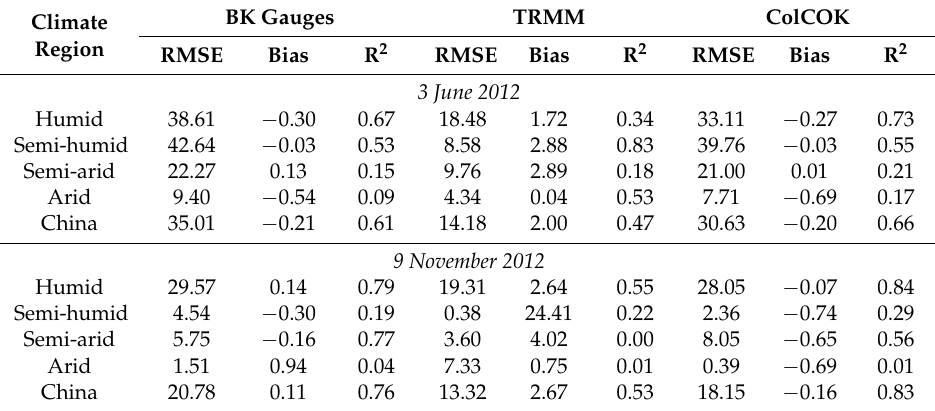
Figure 3. Maps of daily rainfall (mm) measured at ( a ) BK gauges, ( b ) Tropical Rainfall Measuring Mission (TRMM), and ( c ) collocated cokriging (ColCOK) for 3 June 2012; and ( d ) BK gauges, ( e ) TRMM, and ( f ) ColCOK for 9 November 2012 at 0.25° × 0.25° grid across China. Table 2. Overall performance of the validation results of TRMM and ColCOK estimates in comparison to rain gauge measurements for 3 June 2012 and 9 November 2012 for each of the 217 testing rain gauges across